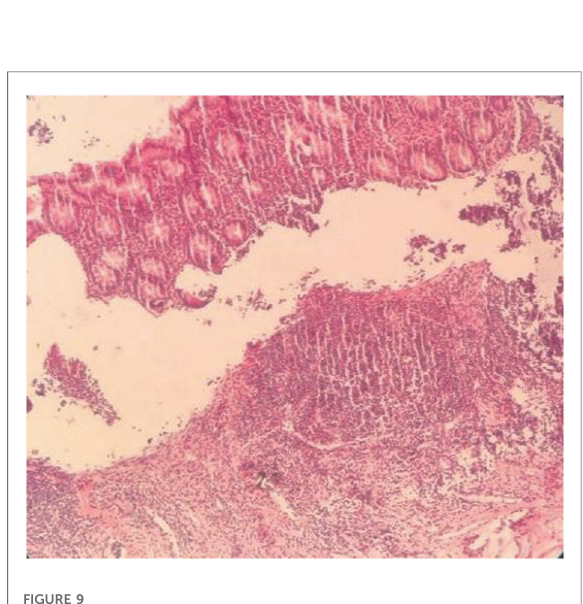
FIGURE 9 In fl ammatory manifestation (magni fi